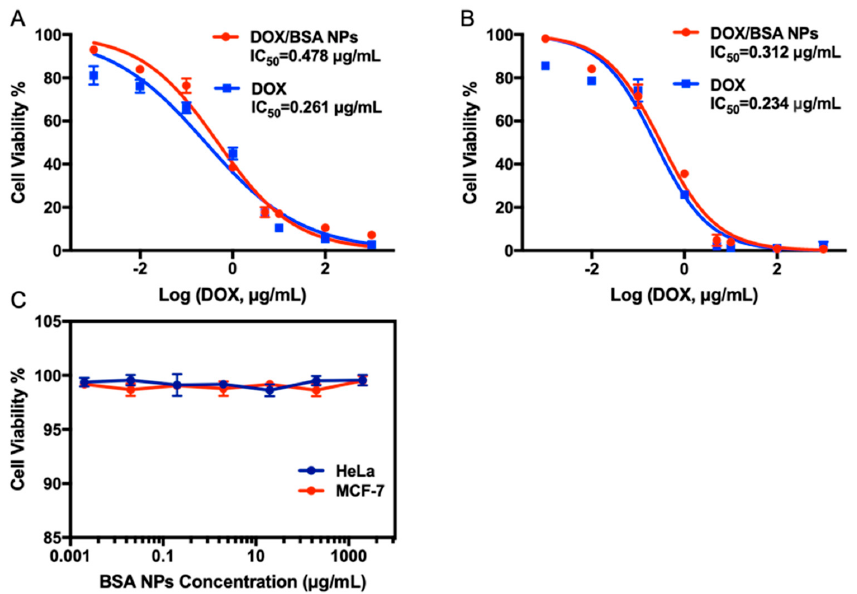
Figure 6. Cytotoxicity of empty BSA NPs and DOX/BSA NPs against cancer cells. The cell viability of HeLa cells ( A ) and MCF-7 cells ( B ) after 48 h incubation with free DOX and DOX/BSA NPs. ( C ) HeLa and MCF-7 cell viability after incubated (48 h) with BSA NPs. Data are presented as mean ± SD, n = 6.